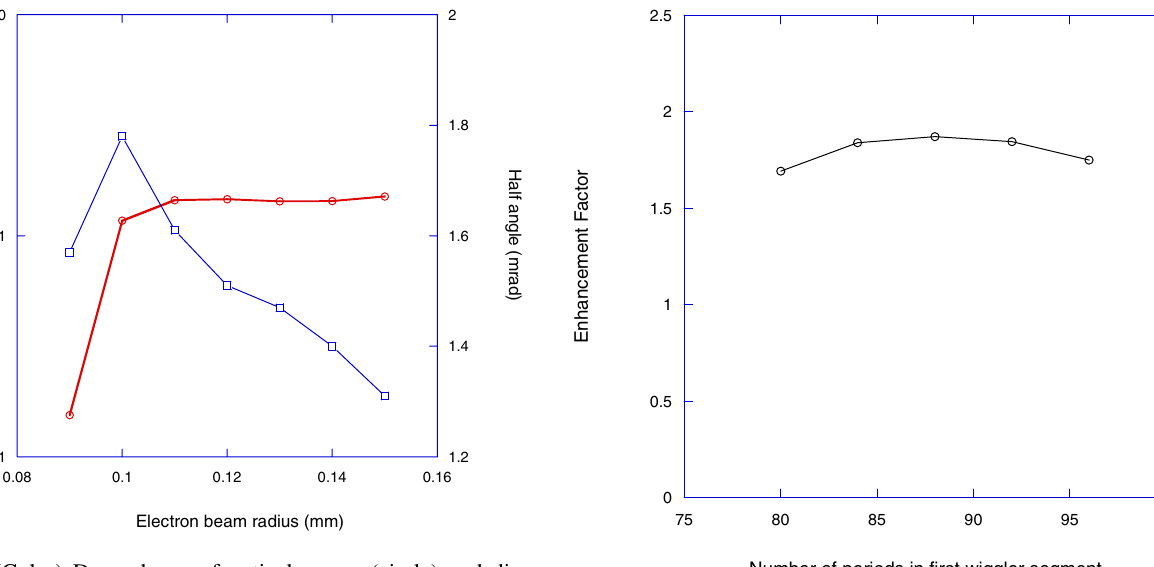
FIG. 10. (Color) Dependence of optical power (circle) and di- vergence half-angle (square) on the minimum electron beam